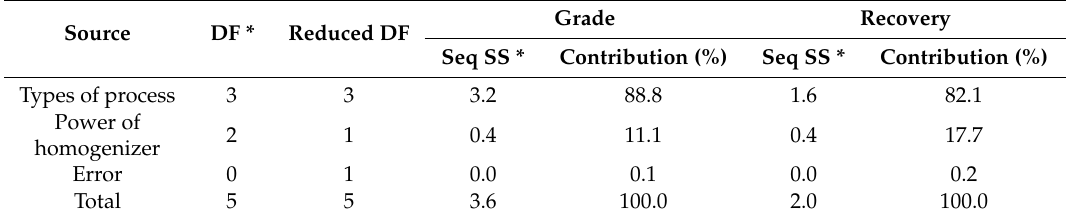
Table 7. Results of the analysis of variance for chalcopyrite grade and recovery in the rougher stage.